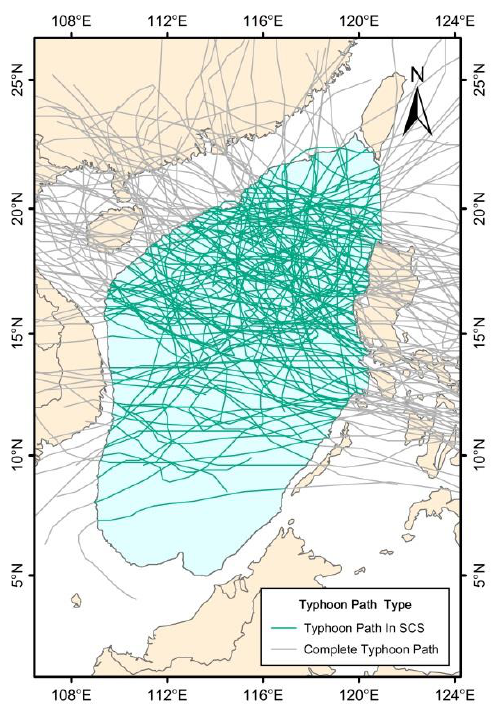
ISPRS Int. J. Geo-Inf. 2016 , 5 , 169 Figure 3. Distribution of TC tracks in the SCS from 1993 to 2013. Figure 3. Distribution of TC tracks in the SCS from 1993 to 2013.